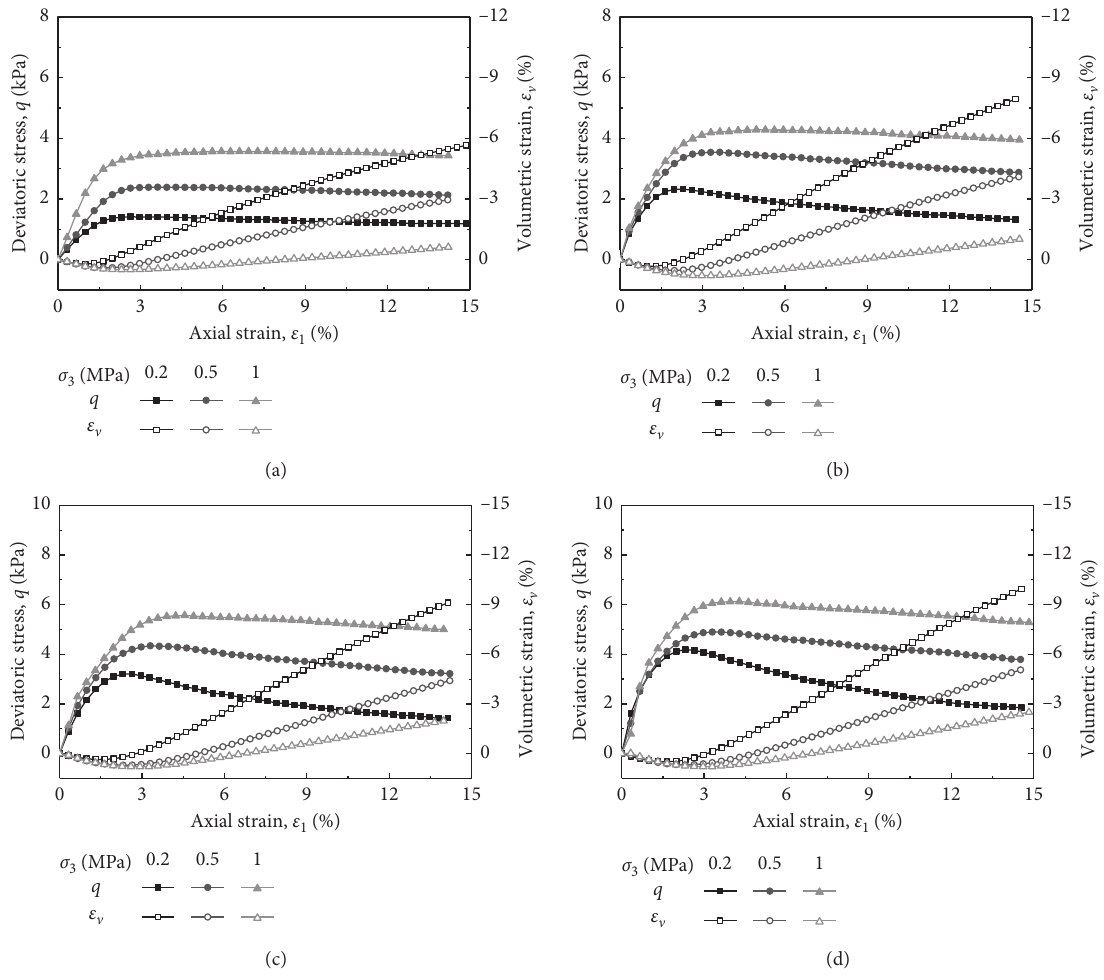
Figure 4: Stress-strain behaviors under different testing temperatures and confining pressures: (a) T � − 2 ° C; (b) T �− 5 ° C; (c) T �− 10 ° C; (d) T �− 15 °